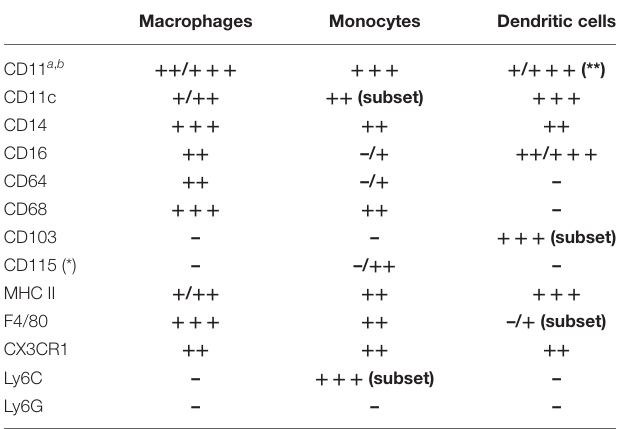
TABLE 1 | Potential surface markers for classifying renal MPC populations in